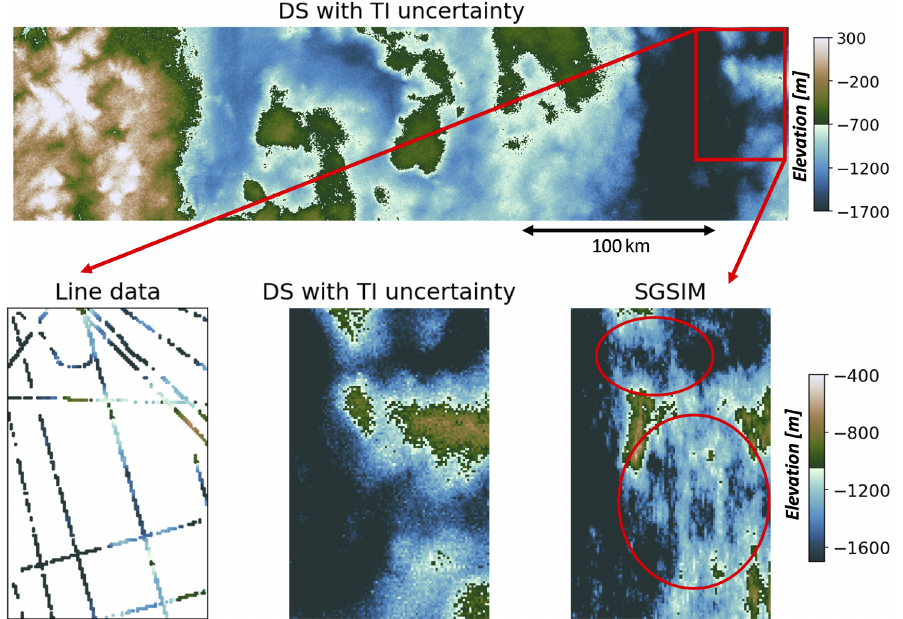
Figure 14. Comparison of SGSIM and the proposed method of DS with uncertain TI sampling in a local sparse line area. Red ovals highlight the areas where SGSIM does not to simulate morphologically meaningful channels.